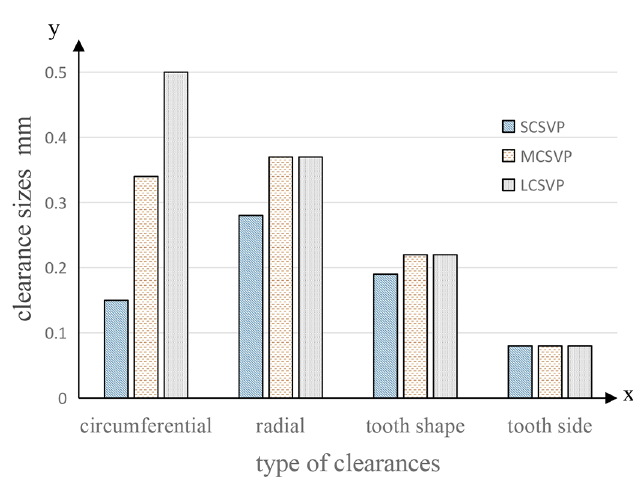
Fig. 7. Different clearance sizes of three kinds of vacuum